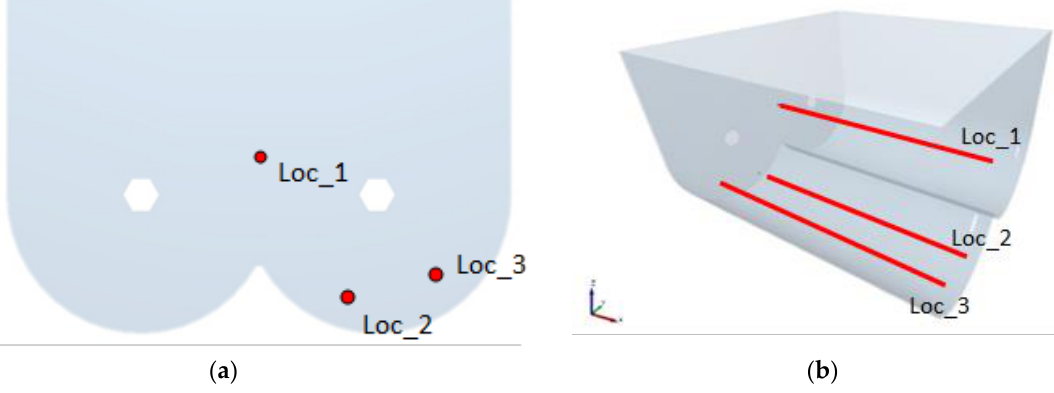
Figure 4. Location identification for granular temperature extraction. ( a ) Front view of paddle mixer with location IDs and ( b ) isometric view of paddle mixer where the evaluation points are equally distributed on the red lines.